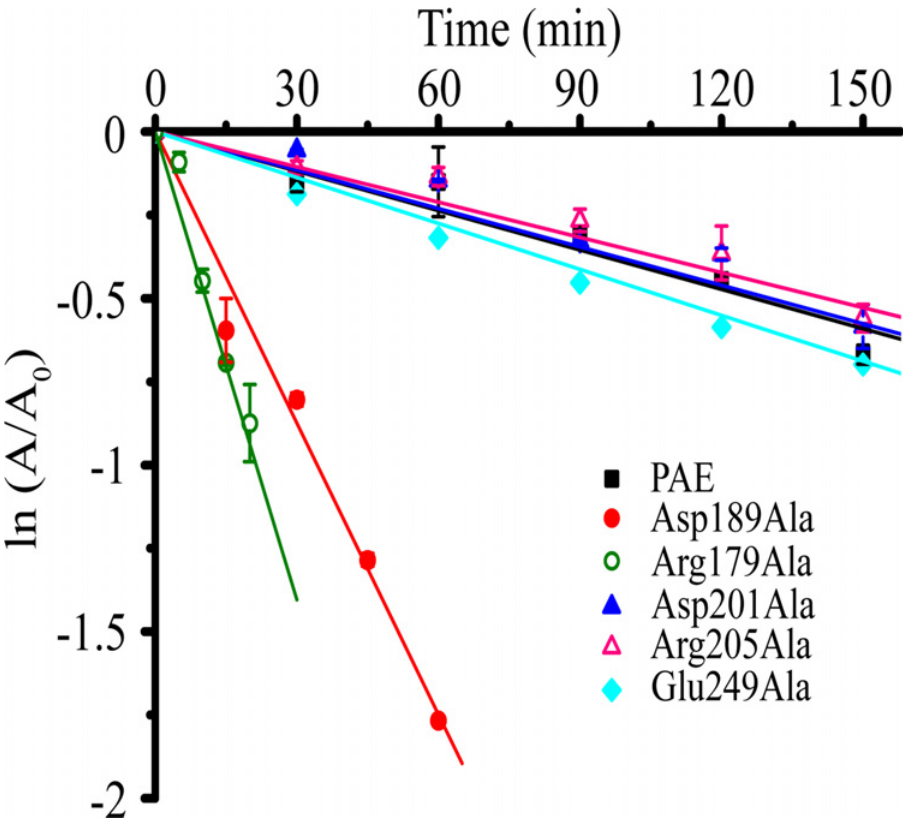
Fig 4. Thermal inactivation of PAE and the active mutants at 60°C. The half-life t 1/2 was calculated by linear fitting using equation ln ( A / A 0 ) = -0.693/ t 1/2 * t . The vertical axis shows the natural logarithm of the residual activity [ln ( A / A 0 )]. The half-life t 1/2 corresponds to the point ( t 1/2 , -0.693) on the fitted